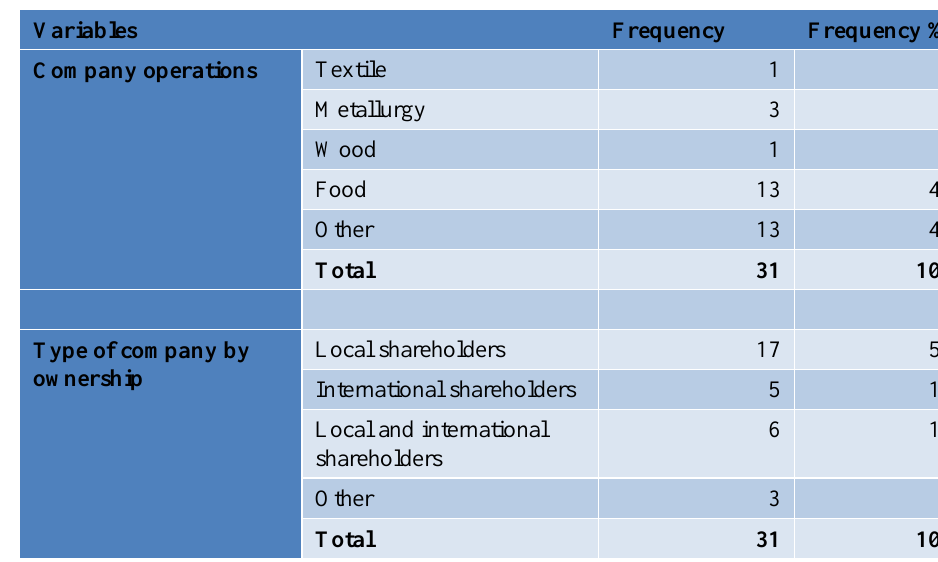
Table 3. General characteristics of enterprises [Table and calculations made by